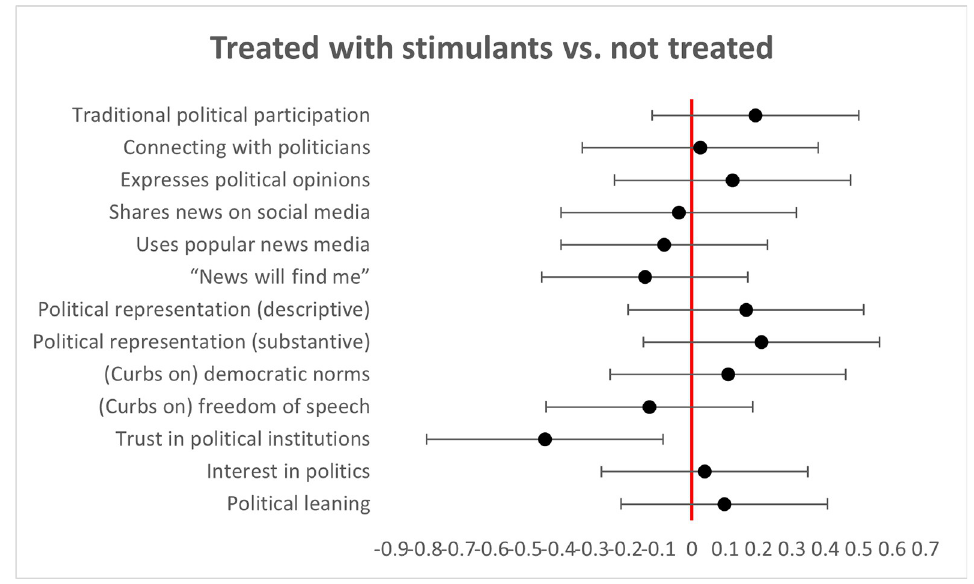
Fig 2. Note. Individuals who screened positive for ADHD but were not taking stimulant drugs to treat their symptoms showed no significant differences in their political behaviors and attitudes compared to all respondents who reported taking stimulants regardless of their ASRS-6 scores in any parameter except trust in political